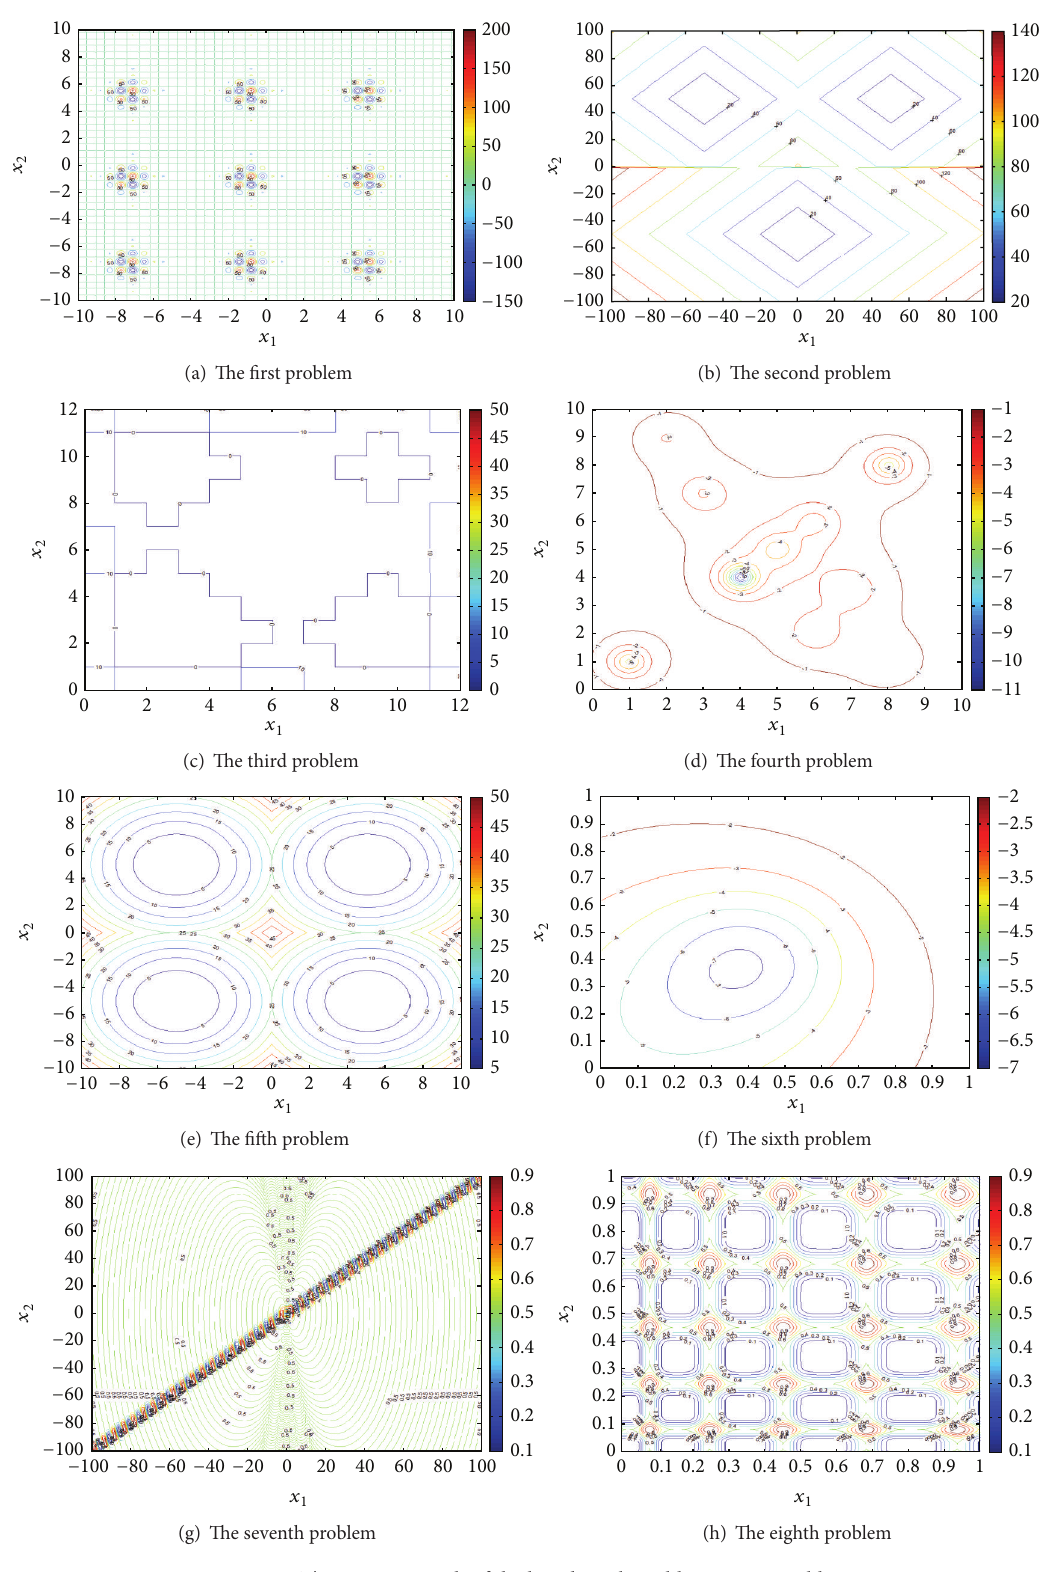
Figure 3: The contour graph of the benchmark problems in 2